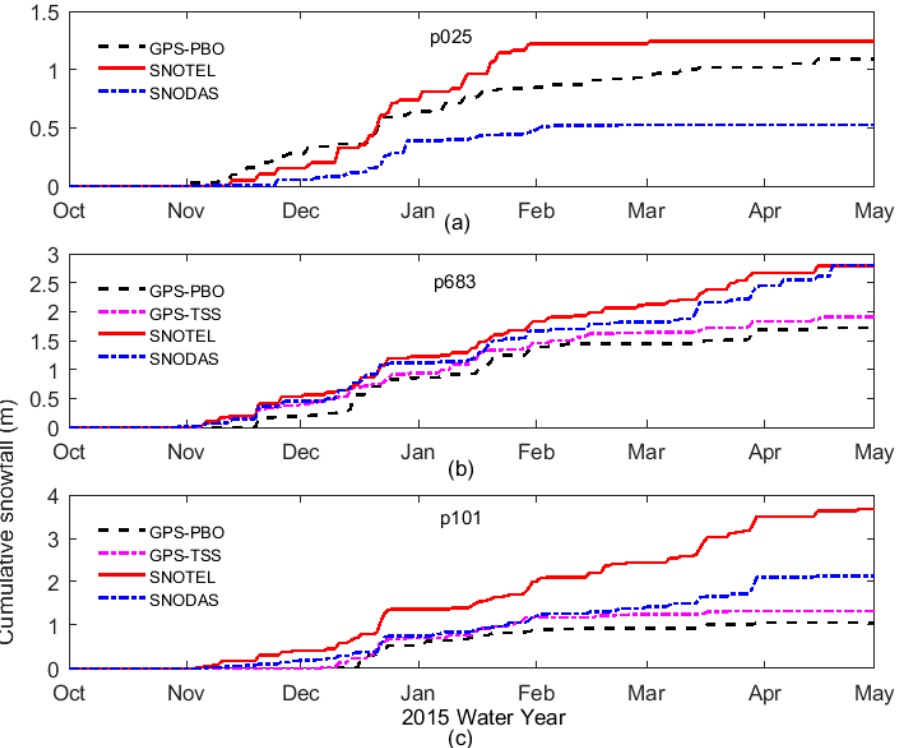
Figure 9. Time series of cumulative snowfall computed with GPS-PBO, GPS-TSS, SNOTEL, and SNODAS during water year 2015 for p025 ( a ), p683 ( b ), and p101 ( c ).